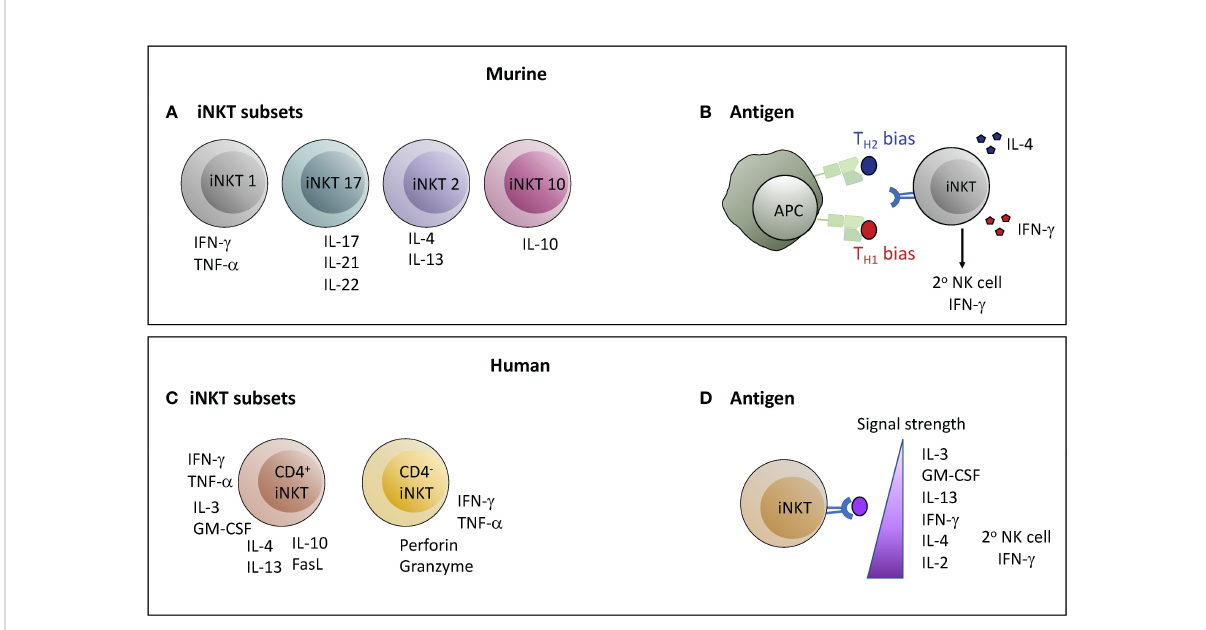
FIGURE 2 Determinants of the nature of the functional response mediated by iNKT cells. In both mice and humans the nature of the response mediated by iNKT cells may depend on the subset of iNKT cells activated or on the characteristics of the antigenic stimulation leading to activation. However, there are important differences between mice and humans in each of these parameters. (A, C) Murine iNKT cells can be classi fi ed into four lineages with functionally segregated cytokine pro fi les; whereas the two major subsets of human iNKT cells are characterized by comparatively polyfunctional cytokine production (CD4 + ) or a more T H1 /cytotoxic pro fi le (CD4 - ). (B, D) Structural features of lipid antigens can bias murine iNKT cell responses towards either a T H1 or T H2 output, whereas human iNKT cell cytokine production proceeds in a hierarchical manner depending on the strength of the TCR signal. Antigens that stimulate a T H1 -biased response in mice typically also produce a strong secondary wave of IFN- g production by NK cells, whereas strong agonists produce this effect from human iNKT